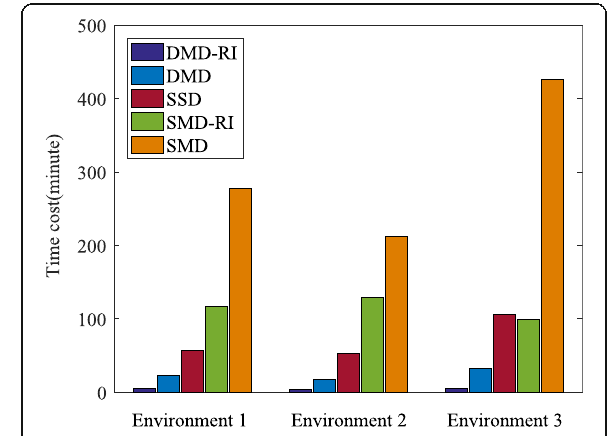
Fig. 14 CDF of errors under different approaches Fig. 15 Time cost corresponding to different